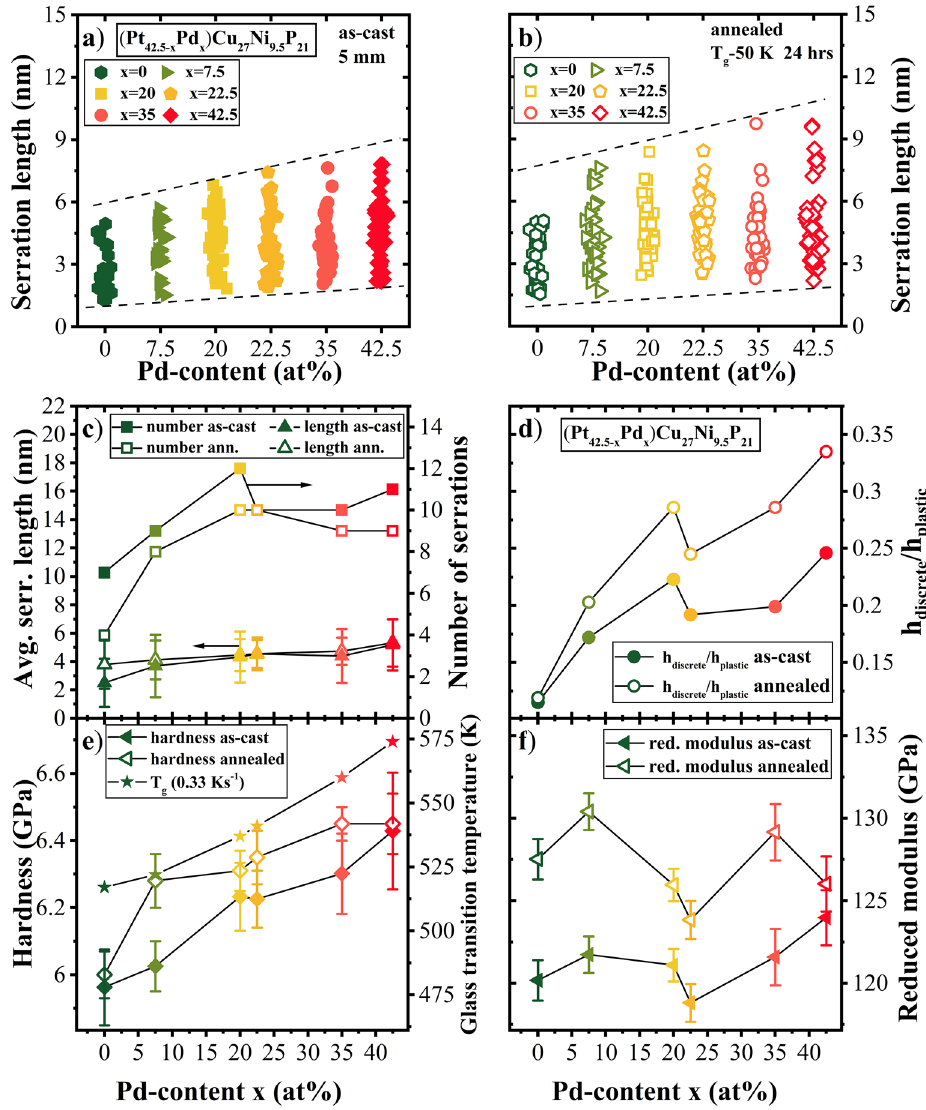
Figure 2. ( a ) and ( b ) Distribution of serration lengths for Pt 42.5−x Pd x Cu 27 Ni 9.5 P 21 bulk metallic glasses as a function of Pd content (i.e., x = 0, 7.5, 20, 22.5, 35, 42.5) in as-cast and annealed states; ( c ) average serration length and serration frequency, ( d ) plasticity ratio, ( e ) hardness and glass transition temperature, and ( f ) reduced modulus for Pt hardness and modulus with increasing Pd content is seen. Annealing of the samples leads to similar increase in hardness and